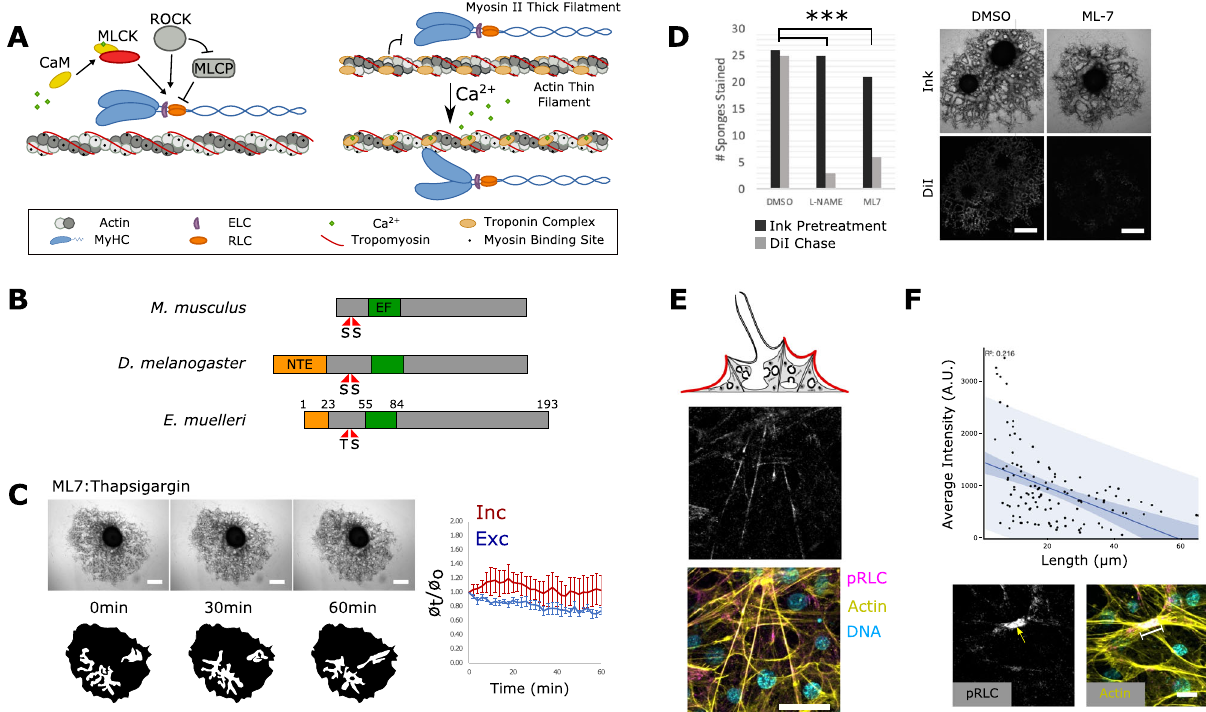
Fig. 4 Contractions require MLCK activity. A Fast-contracting myocytes are regulated by the Troponin C/Tropomyosin complex, whereas slow- contracting myocytes are regulated by the MLCK pathway. B Predicted domain structure of E. muelleri RLC; a 23 amino acid N-terminal extension (NTE) exists based on the location of phosphorylatable residues and EF-hand domain. C 1 nM thapsigargin had limited effect on sponges pretreated with 1 µ M ML- 7 to inhibit MLCK activity ( n = 6 individual measurements) Data are presented as mean values + / − SEM. D Sponges were treated with Sumi Ink to block water fl ow, then treated with DiI to test for restored fl ow as an indicator of contractile activity. The ratio of sponges that stained positive for DiI was signi fi cantly lower following treatment with 50 μ g/mL L-NAME and 1 µ M ML-7 compared with DMSO treated controls ( χ 2(df2, N = 70) = 13.08, P - value = 0.001). Contraction assays were performed three independent times with consistent results. E pRLC (grayscale and magenta) immunostaining of the apical pinacoderm, counterstained with phalloidin (yellow) and Hoechst (cyan). F Scatter-plot generated by overlaying pRLC and F-actin images